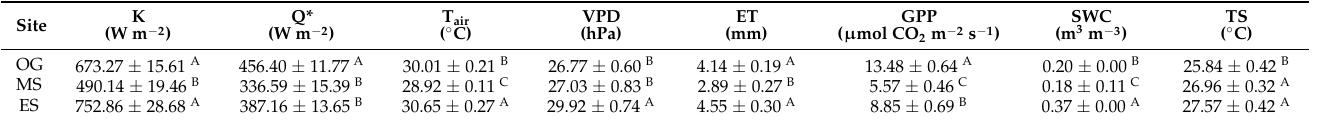
Table 5. Annual means of global radiation (K), net radiation (Q*), air temperature (T air ), vapor deficit pressure (VPD), evapotranspiration (ET), gross primary production (GPP), soil volumetric water content (SWC) and soil temperature (TS) along a forest succession from tropical dry forest in northwestern Mexico. Data are presented as mean ± standard error. Capital letters denote significant differences among sites ( p <